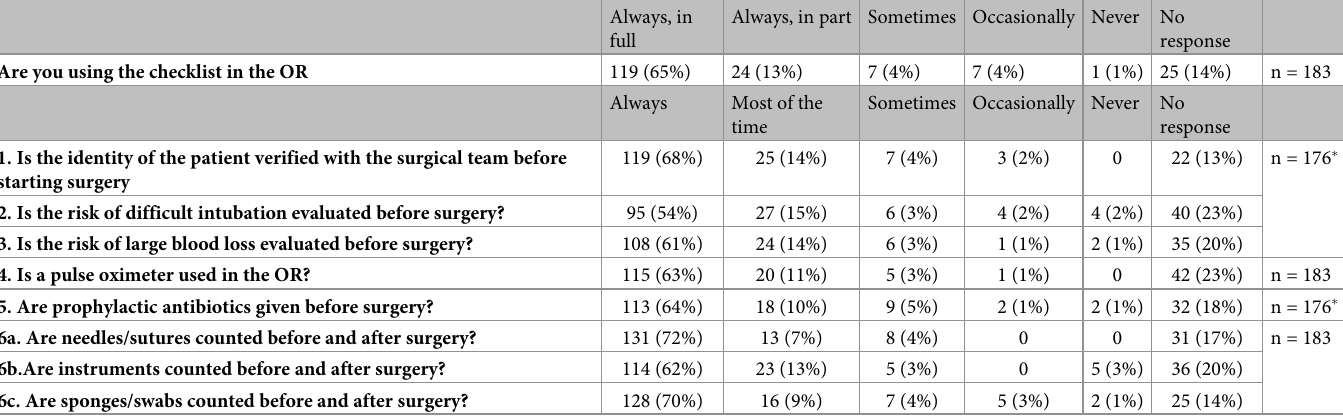
Table 4. Frequency of self-reported use of the checklist and the six basic safety processes. Values given as numbers (percentage).